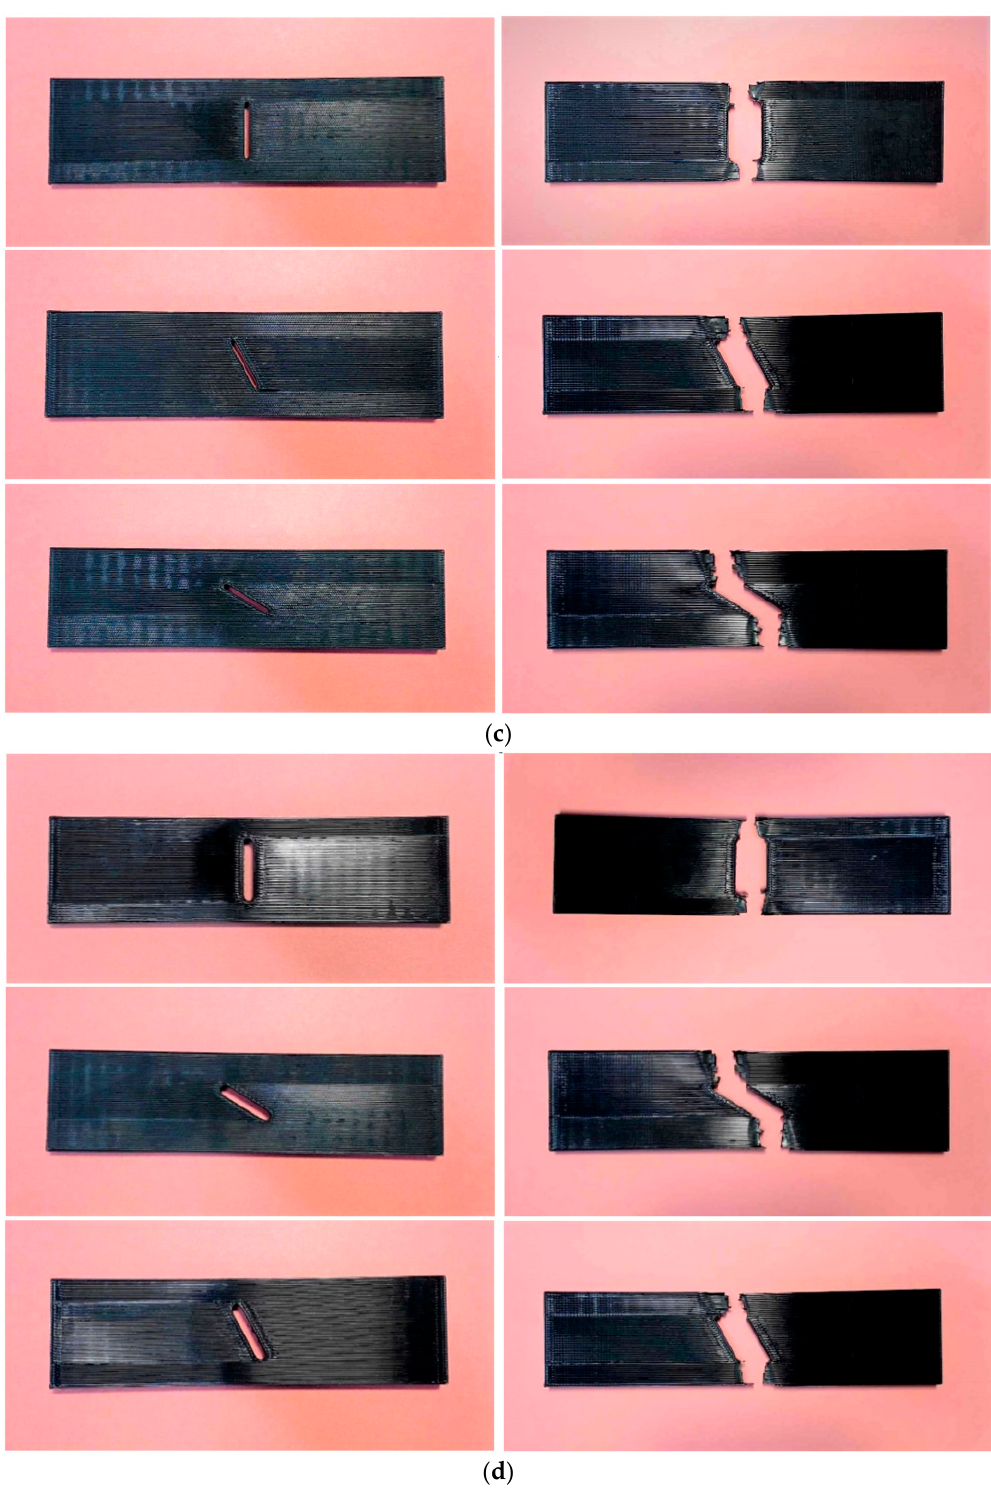
Figure 5. 3D-printed specimens before (left) and after (right) rupture; ( a ) MJF nylon, r = 1 mm, ( b ) MJF nylon, r = 2 mm, ( c ) FDM nylon, r = 1 mm and ( d ) FDM nylon, r = 2